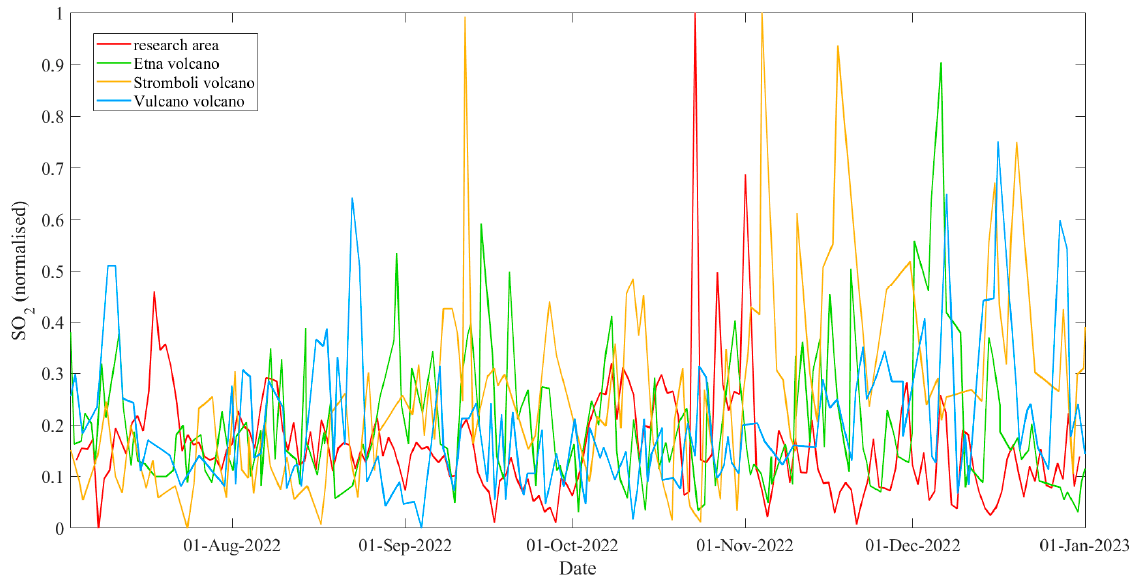
Figure 7. Comparison of SO 2 time series in the research area with SO 2 measured in the craters of three active close volcanos: Etna, Stromboli, and Vulcano. All the data were normalised in the range from 0 to 1.